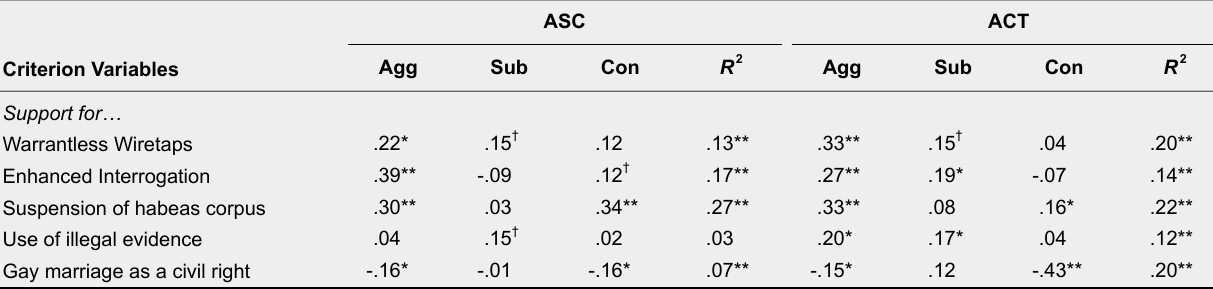
Beta Coefficients for ASC and ACT Scales Predicting Support for Anti-Democratic Policies in Sample